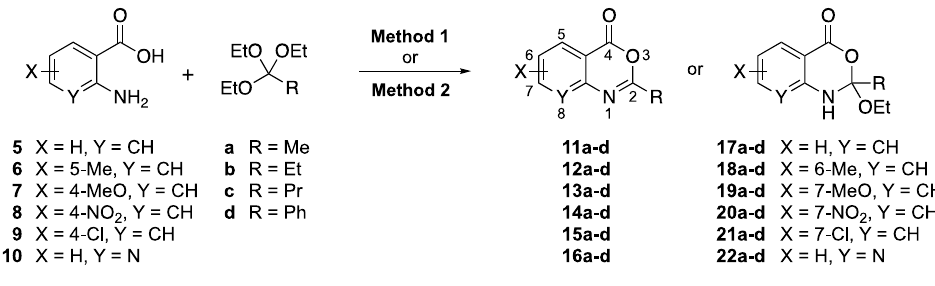
Figure 1. 4 H -Benzo[ d ][1,3]oxazin-4-ones with potential drug activity.